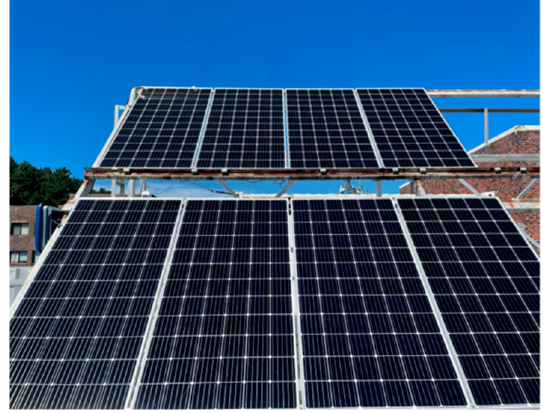
Figure 2. Photovoltaic system overview.